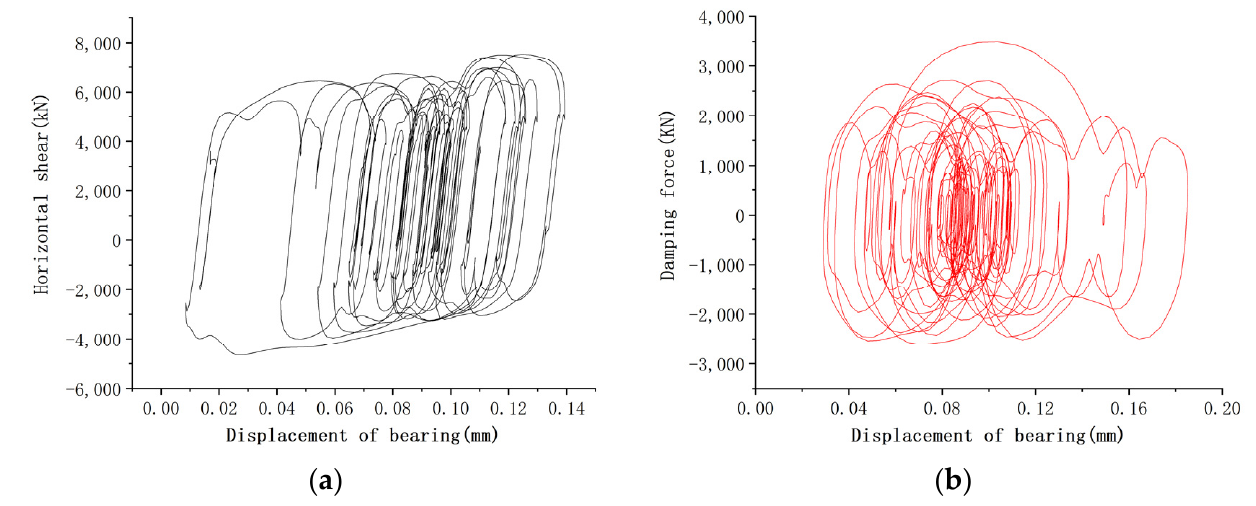
Figure 15. Hysteresis curve of piers adopting the CSDI scheme. ( a ) Hysteresis curve of the 1# pier using FPB. ( b ) Hysteresis curve of the 2# pier using dampers.